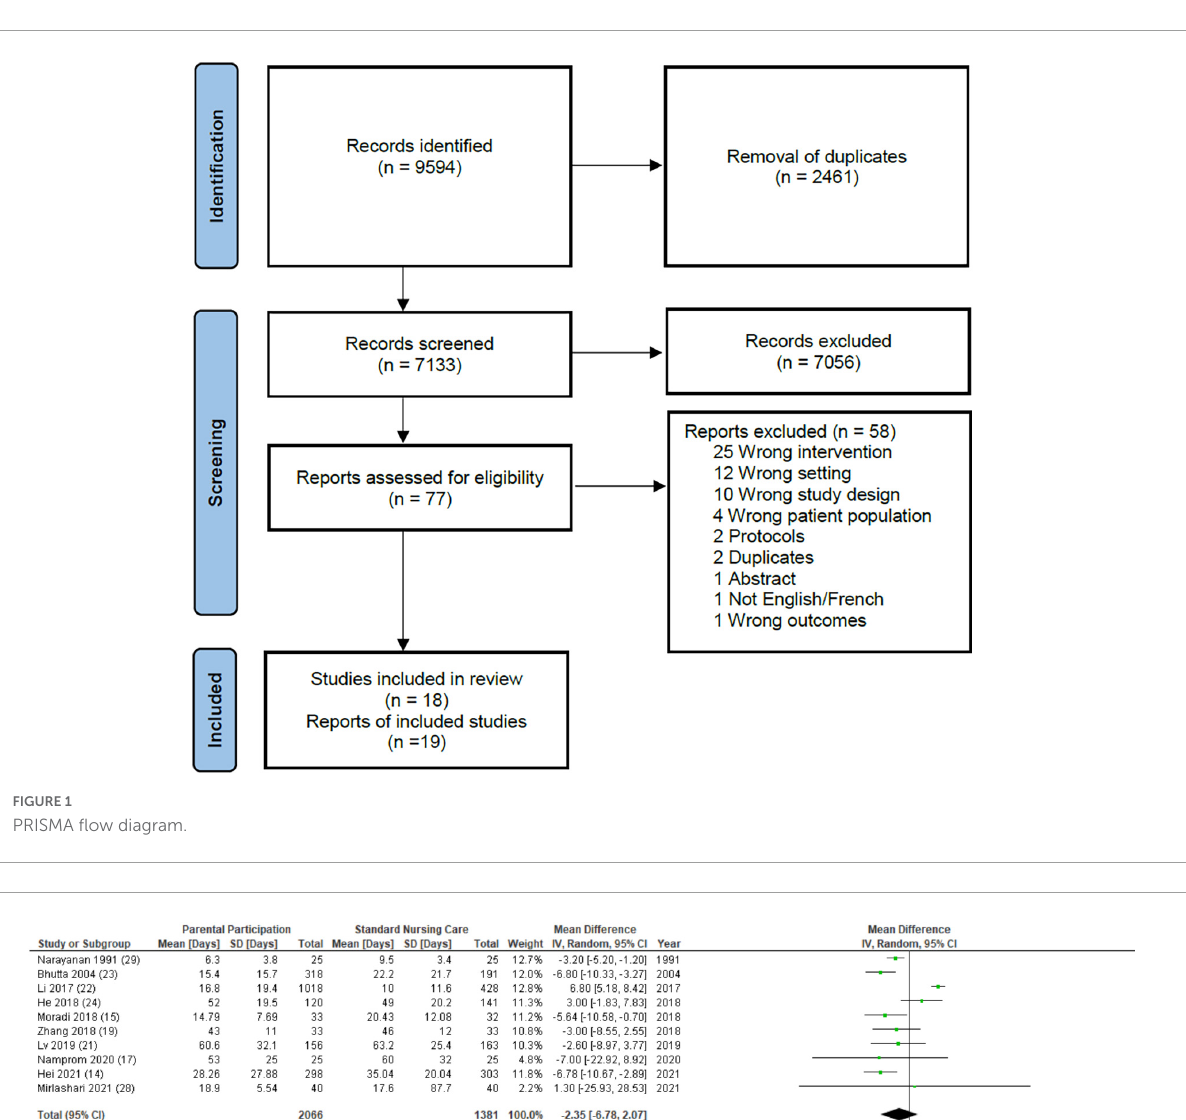
FIGURE2 Forest plot and meta-analysis of the association between parental participation and length of